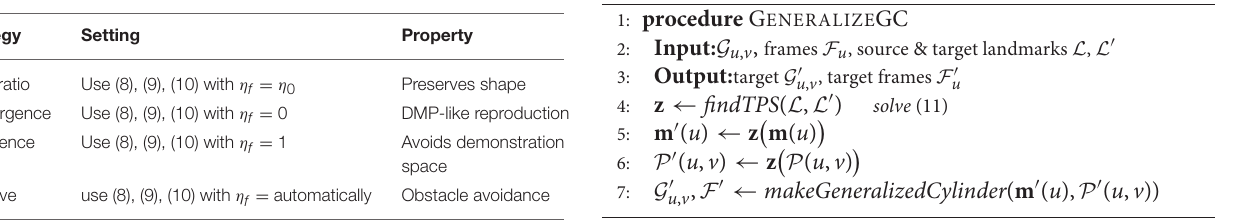
TABLE 1 | A guideline for setting reproduction strategies for TLGC. Algorithm 3 Generalization of GC using